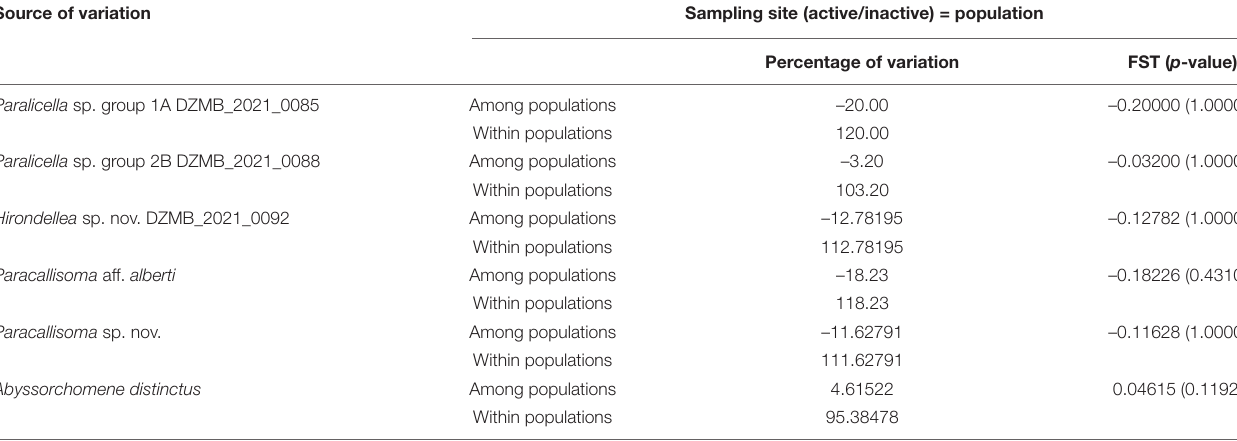
TABLE 5 | Analysis of molecular variance (AMOVA) based on pairwise difference among haplotypes; significance calculated by 1,000 permutations of the COI dataset.